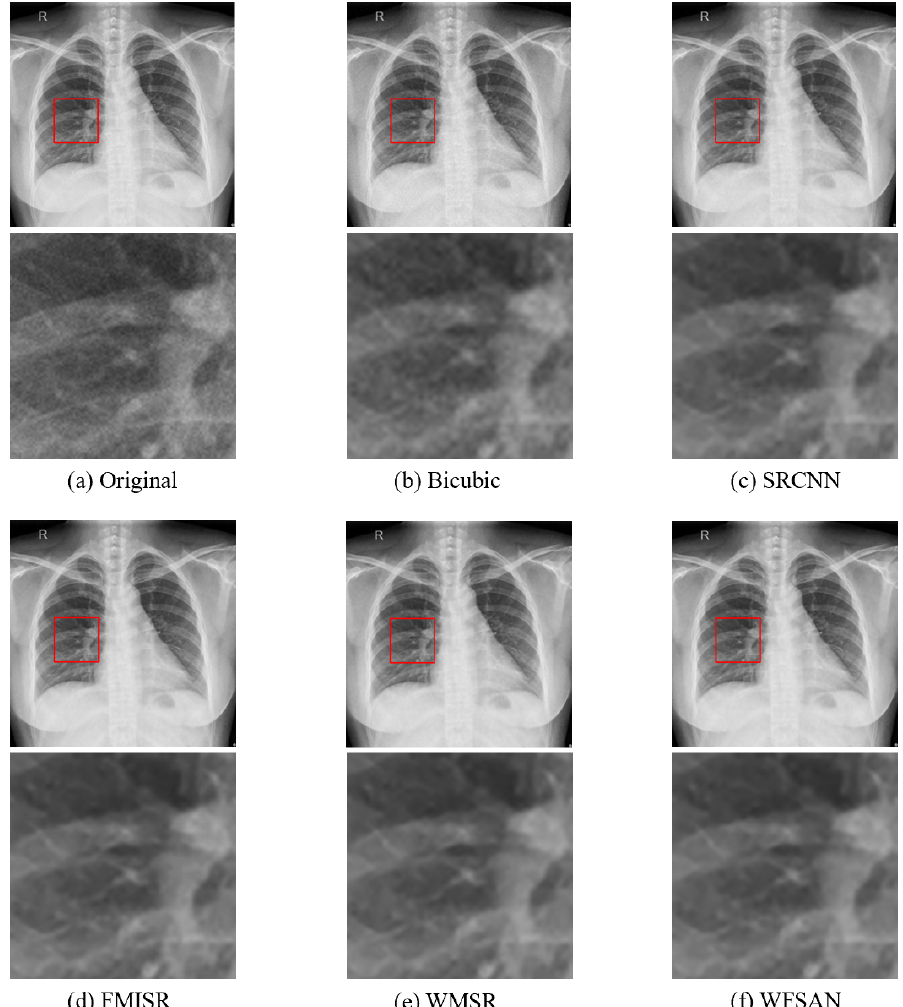
Figure 8. Visual comparison of different models in ChinaSet normal chest dataset, ( a ) Original(HR) image, ( b ) Bicubic, ( c ) SRCNN, ( d ) FMISR, ( e ) WMSR, ( f )